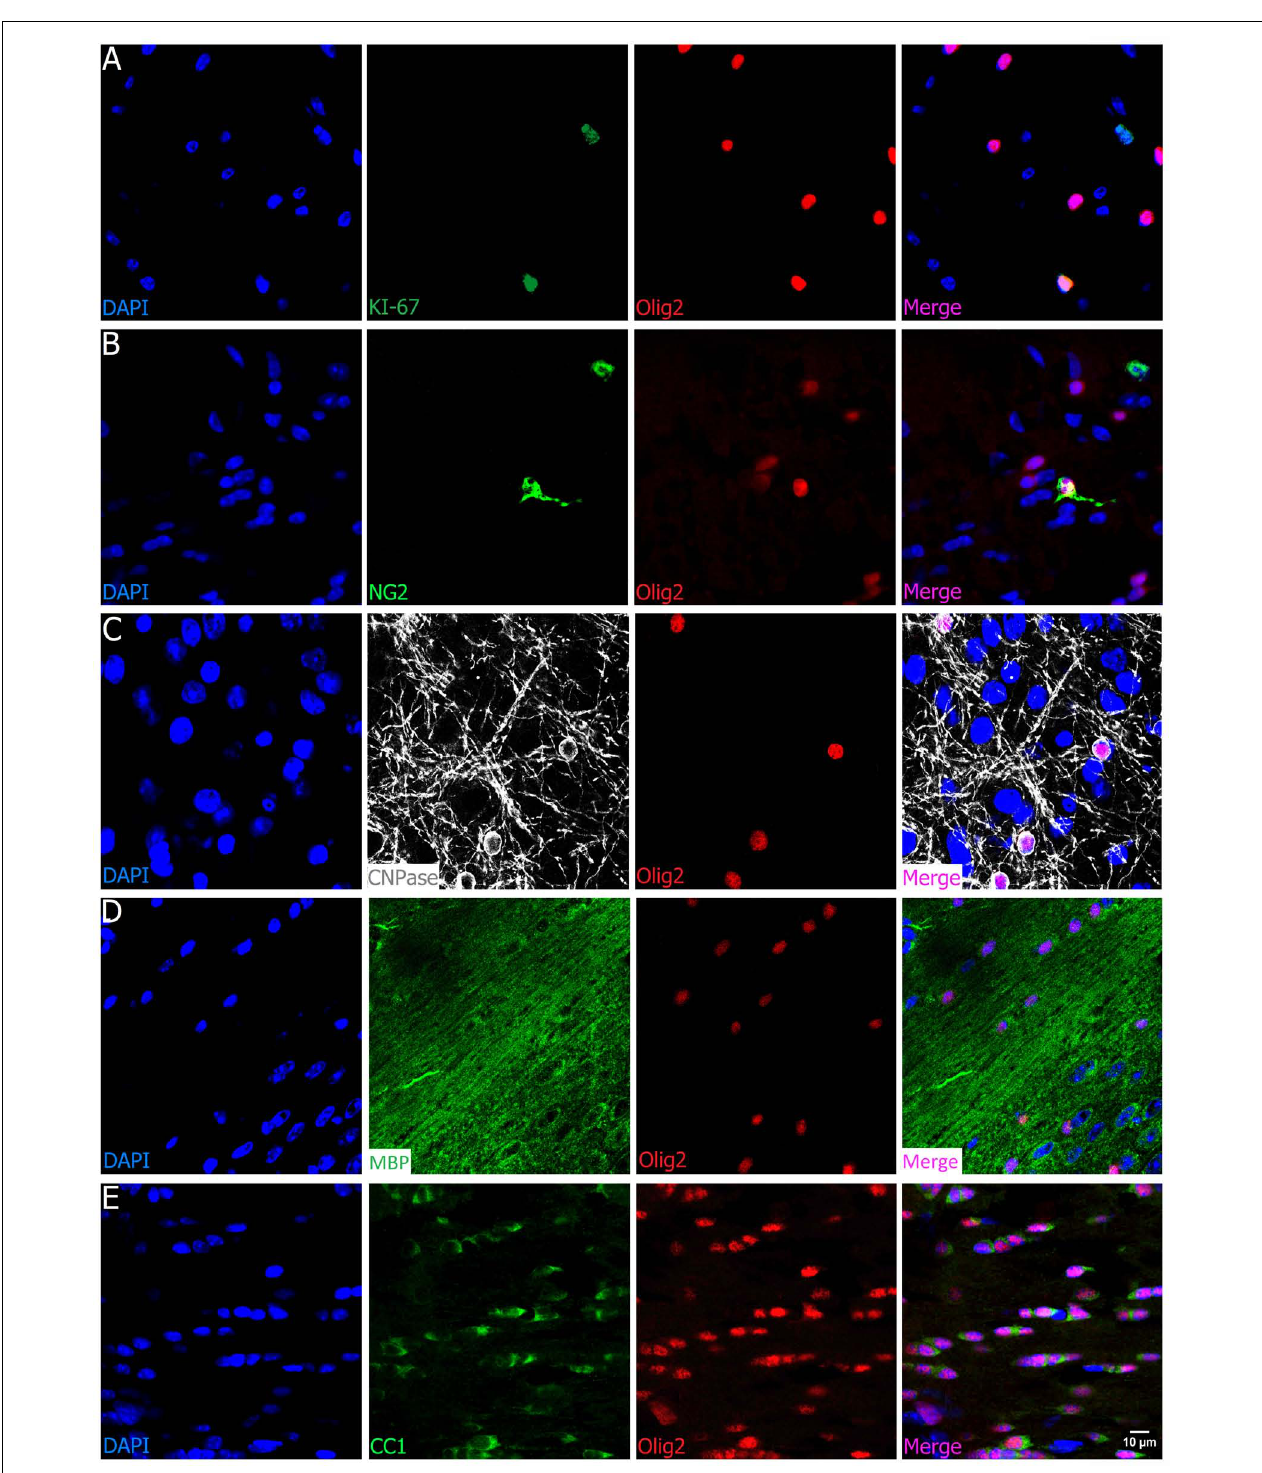
FIGURE 4 | Olig2 is an oligodendrocyte universal marker. Olig2 (red) colocalizes ( A , cortex and corpus callosum) with cell cycle KI-67 marker (green) as seen in the merge picture (orange), and also ( B , cortex) with the chondroitin sulfate proteoglycan NG2 (green), evidence for its presence in the proliferative and migratory precursor population. ( C , olfactory bulb) Olig2 is also present in the pre-myelinating and myelinating phase, since it colocalizes with CNPAse (gray), and ( D , corpus callosum; E , fornix) with well-known adult oligodendrocytes markers such as MBP (green) and CC1, characteristic of the end of maturation. Scale bar (valid for all panels): 10 µ